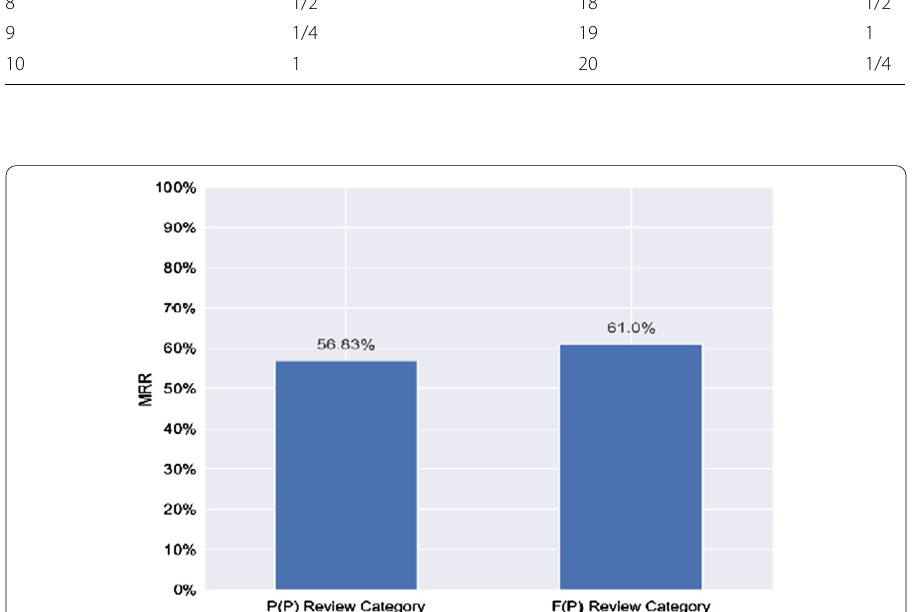
Fig. 9 Comparison of the A(P)‑based MRR results for new items: P(P) review category vs. F(P) review